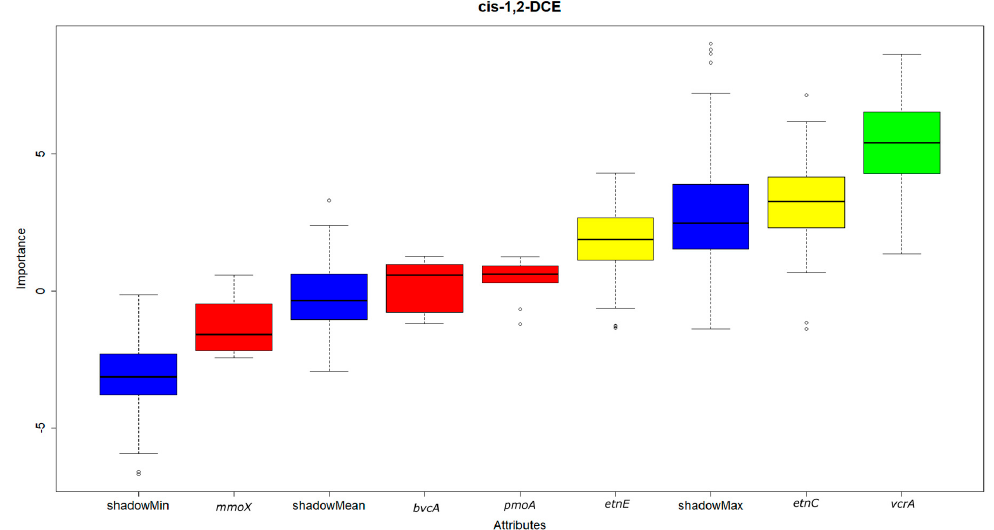
Figure 4. Importance of individual biomarkers on concentration of cis ‐ 1,2 ‐ DCE, based on the Boruta algorithm utilising the random forest classification. Green indicates significant attributes, yellow indicates attributes of intermediate significance while red indicates attributes that are not significant (blue colour indicates shadows—Boruta auxiliary features used for selection of significant attributes).